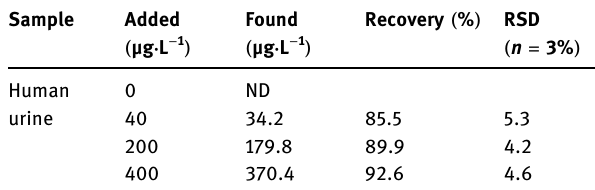
onto FSA - MIPs and FSA - NIPs at di ff erent temperatures